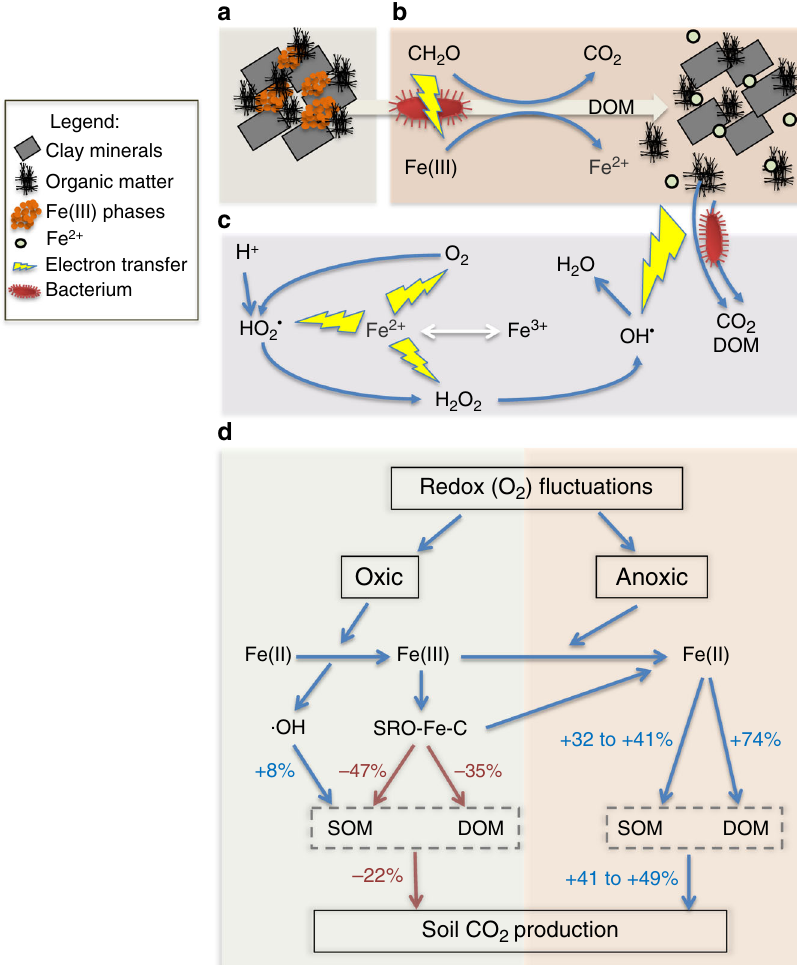
Fig. 1 Schematic of Fe-mediated C transformation. Under oxic conditions, Fe III phases sorb C ( a ). Under anoxic conditions, Fe III can be reduced to Fe II coupled with C mineralization, releasing dissolved organic matter (DOM) ( b ). Fe 2 + oxidation yields reactive O 2 species driving CO 2 and DOM production ( c ). d Conceptual diagram of contrasting positive (blue arrows) and negative (red arrows) changes in CO 2 production linked to a given